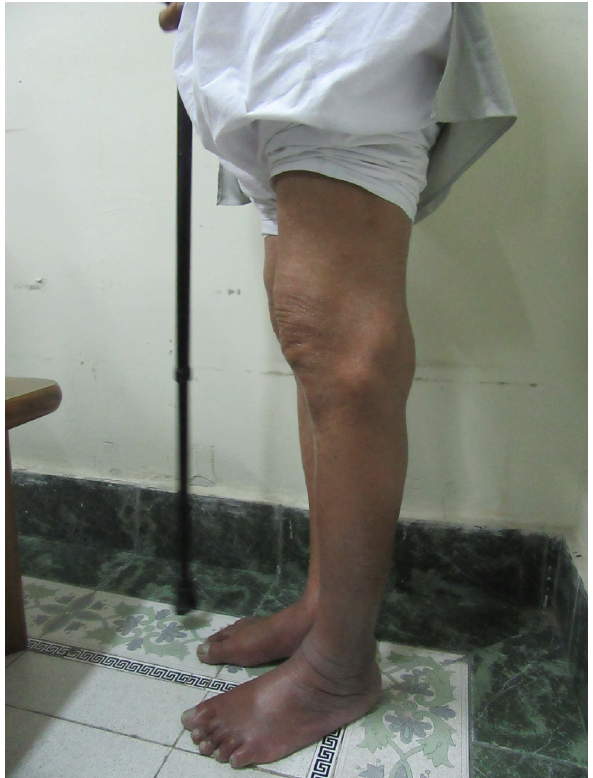
Figure 2. Patient standing with a stick in his hand. From the lateral aspect two swellings can be appreciated. The first swelling was located 1 cm above the lateral joint line and 4 cm lateral from the lateral patellar border and measured 4 cm · 6 cm. The other swelling was located 1 cm below the lateral joint line and 2.5 cm lateral from the lateral patellar tendon measuring 2 cm · 4